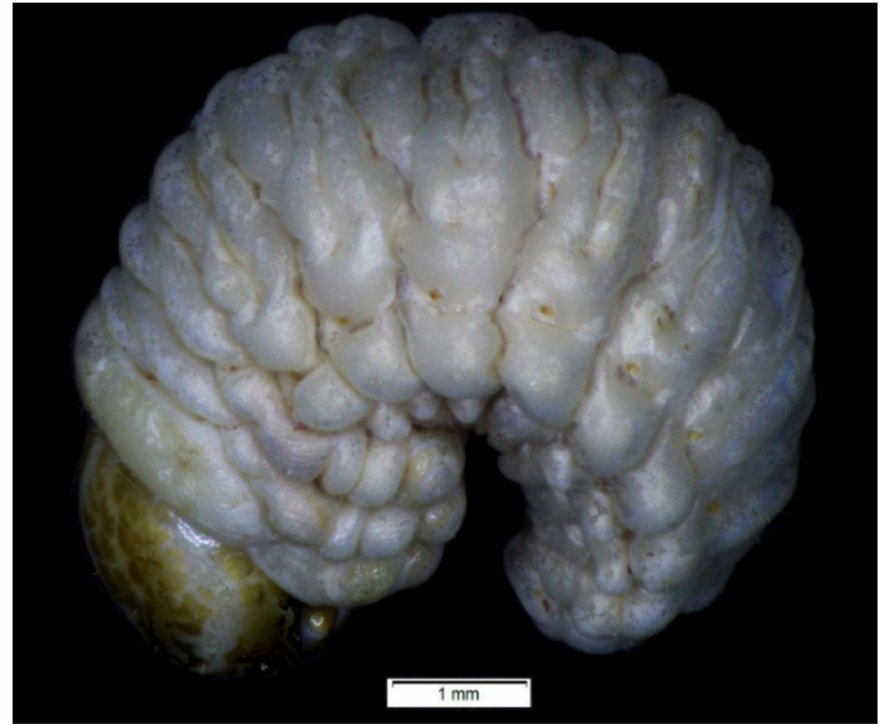
Figure 11. Rhinocyllus alpinus habitus of mature larva, lateral view. Coloration : only pronotal sclerites are brownish; the rest of the thoracic and all abdom- inal segments are white or greyish (Figure 11). Head is brown, covered with irregular dark brown